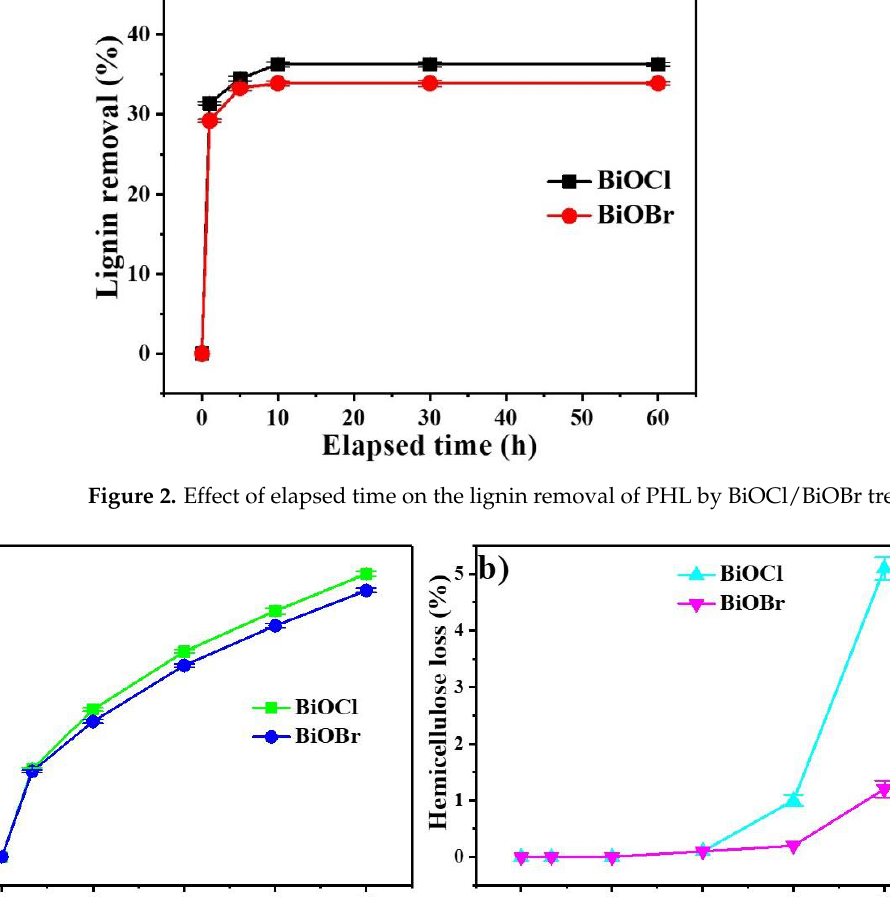
Figure 2. Effect of elapsed time on the lignin removal of PHL by BiOCl/BiOBr treatment.